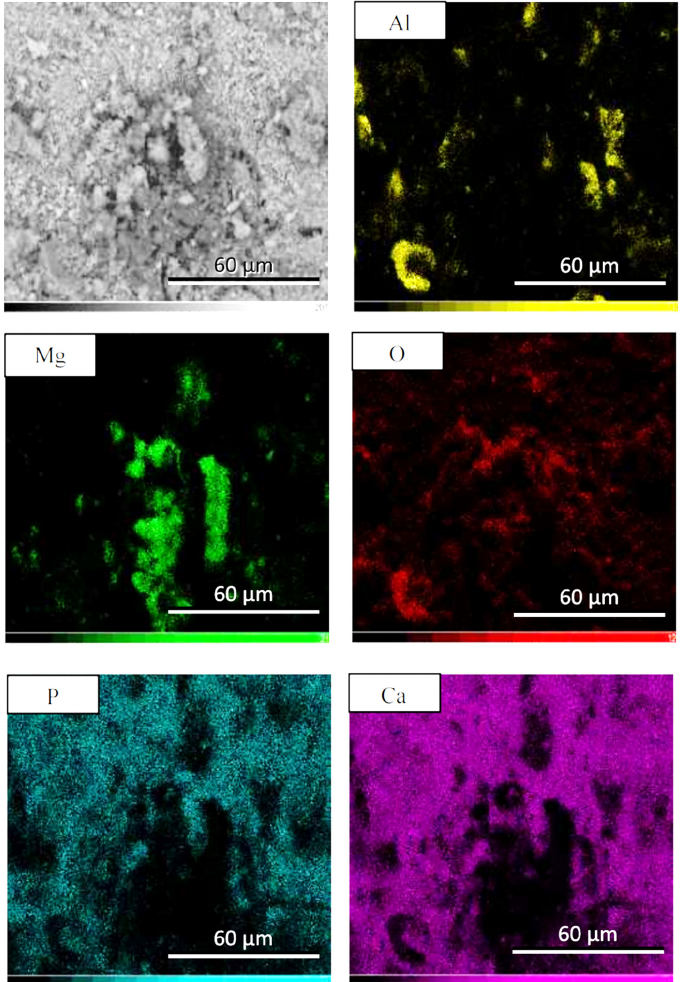
Figure 6. SEM-EDX pictures of the hydroxyapatite composite made by Al particle size of <90 µ m with compaction pressure of 100 MPa.